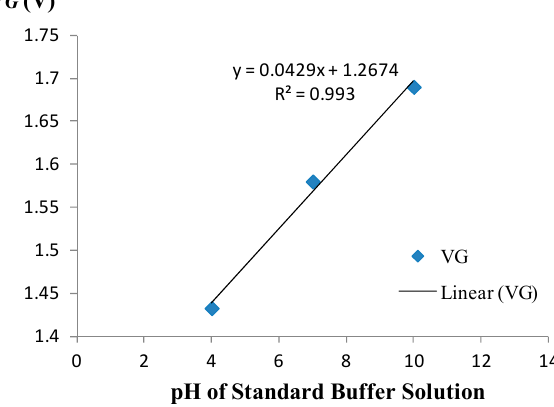
Figure 4. Feedback-mode calibration curve.